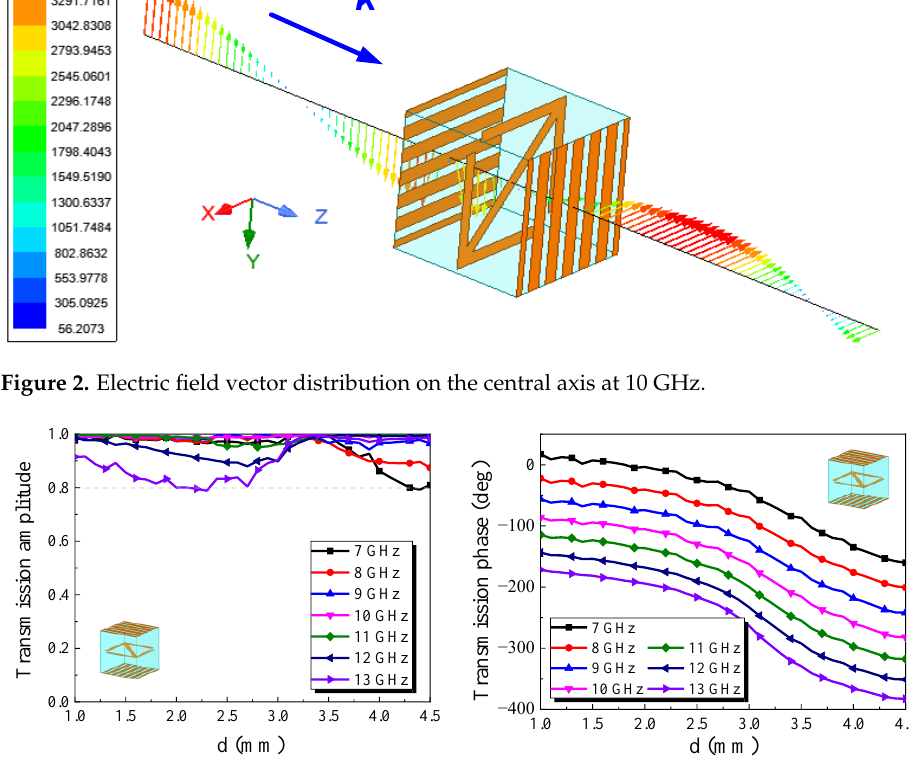
Figure 2. Electric field vector distribution on the central axis at 10 GHz. Figure 3. Simulation results of the element: ( a ) Transmission amplitude; ( b ) Transmission phase.